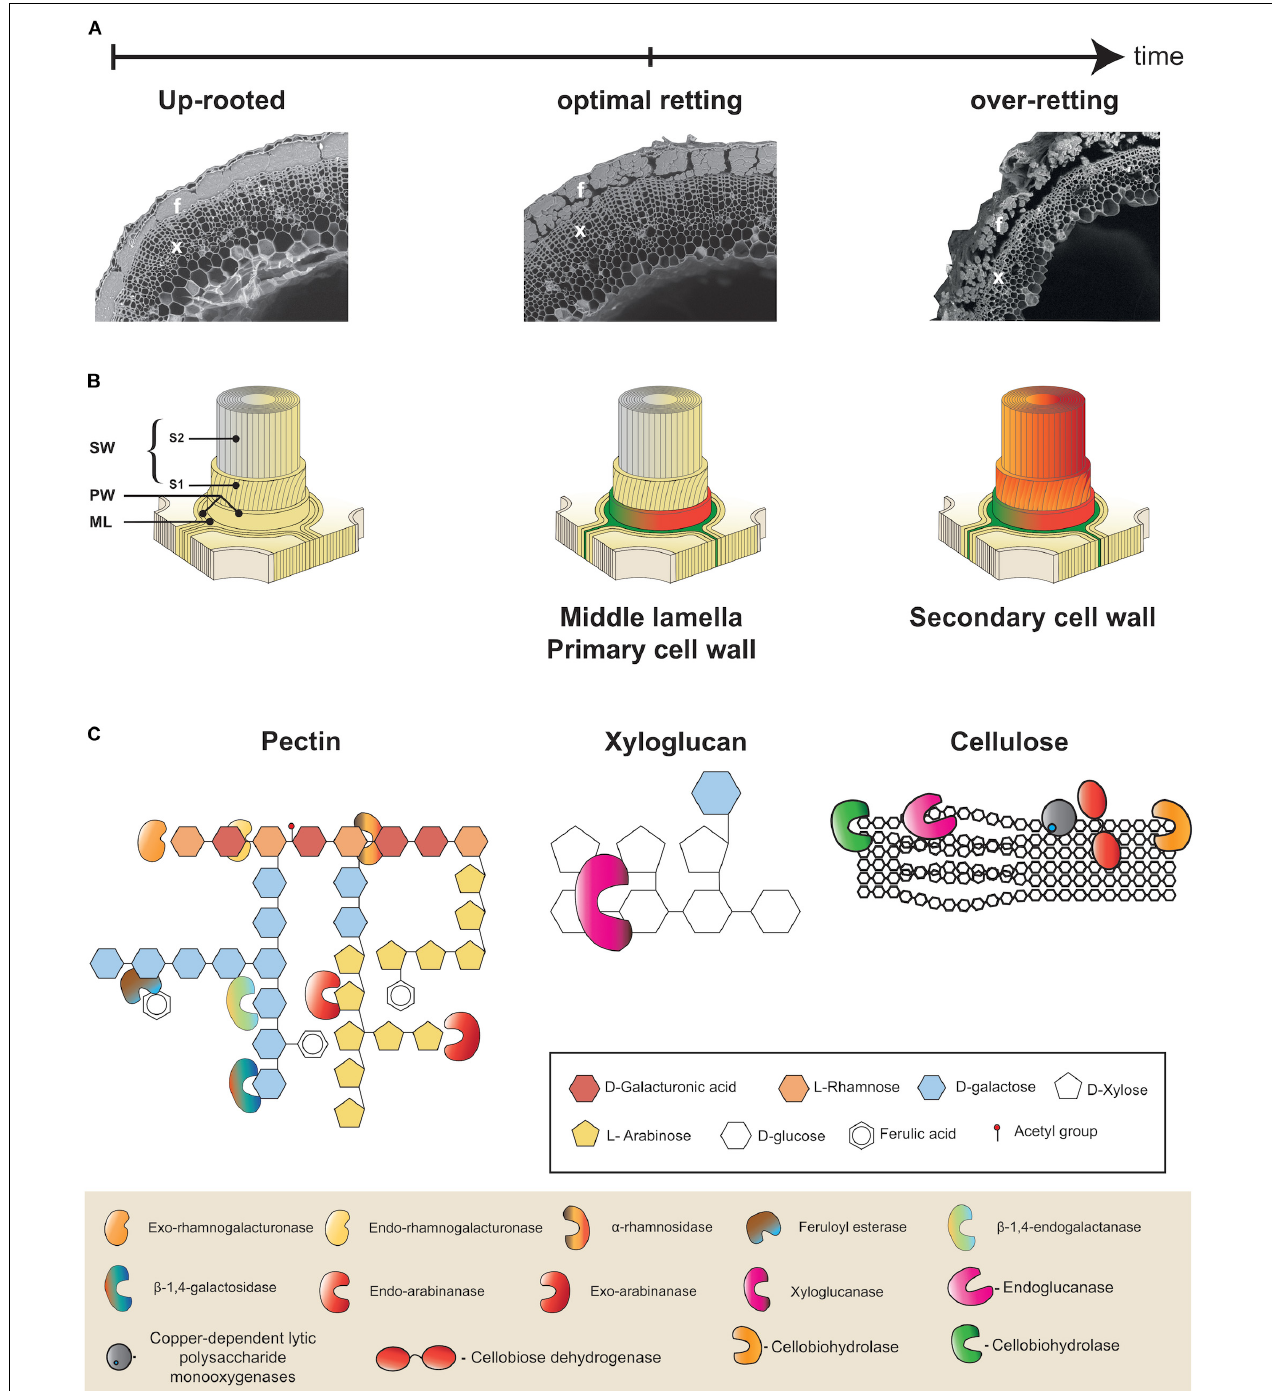
FIGURE 2 | Multiscale presentation of retting process in flax. (A) Microphotographs illustrating progressive changes in flax stem morphology during retting. Appearance of a stem cross-section from a freshly up-rooted plant at the beginning of retting (left) , at the optimal retting (middle) , and over-retted (right) . At optimal retting cortical parenchyma cells are no longer visible and fiber bundle dissociation has started. Bast fibers (f) and xylem (x). (B) Schematic representation of the different layers of a plant cell wall: middle lamella (ML), primary cell wall (PW), secondary cell wall (SW), S1 and S2 layers of the secondary cell wall (S1, S2). All cell wall layers are intact at the start of retting (left) , at optimal retting stage (middle) the middle lamella and primary cell walls of cortical parenchyma cells are degraded (green/orange) and the middle lamella between neighboring fiber cells is starting to become degraded (green/orange). At over-retting, the secondary cell wall of fibers starts to become degraded (right) . (C) Examples of different cell wall polymers: Rhamnogalactan I (RGI) pectin (left) , xyloglucan hemicellulose (middle) , and cellulose (right) . Keys indicate sugar monomers making up polymers ( top frame) and cell wall degrading enzyme activities ( bottom frame). This part was adapted from Polizeli et al.